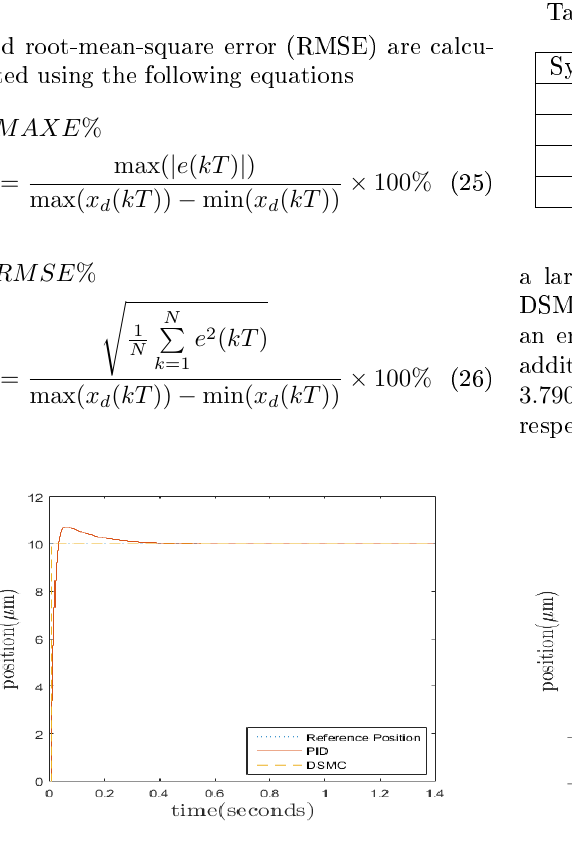
Fig. 5: Tracking performance for step response. The simulations are performed using MAT- LAB. In Fig. 5, the reference position is a con- stant, and PID controller and DSMC are em- ployed with the parameters in Tabs. 2 and 3. The tracking performance using PID controller show an overshoot of approximately of 1 µm and